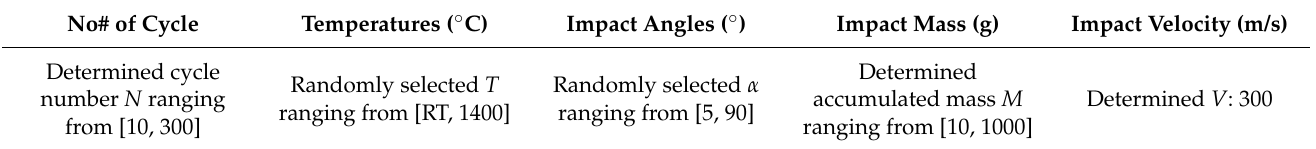
Table 7. Parameters used to calculate erosion rates under different impact velocities.